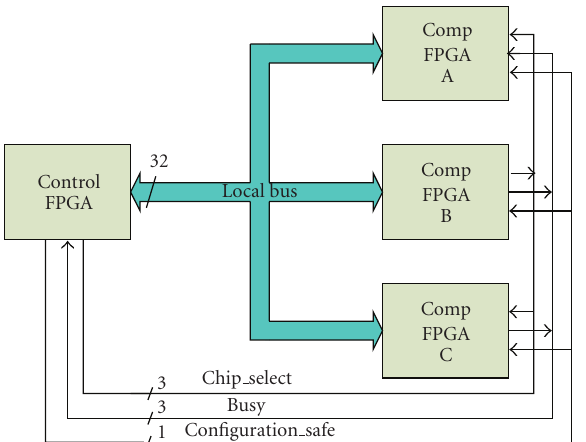
Figure 8: Communication structure during processing mode on an FLC: bidirectional data transfer is only possible via the slower Local Bus(80MB/s).Separate point-to-point links( chip select & busy ) are used for control and synchronization of parallel processes. A further single point-to-point link is connected to all four FPGAs, indicating the current system state, that is, DAQ or processing mode.